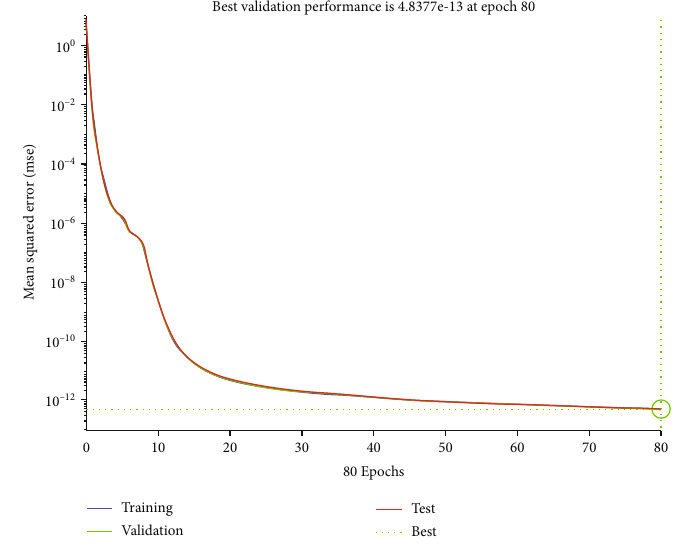
Figure 5: DNN-PV MPPT controller showing the best validation